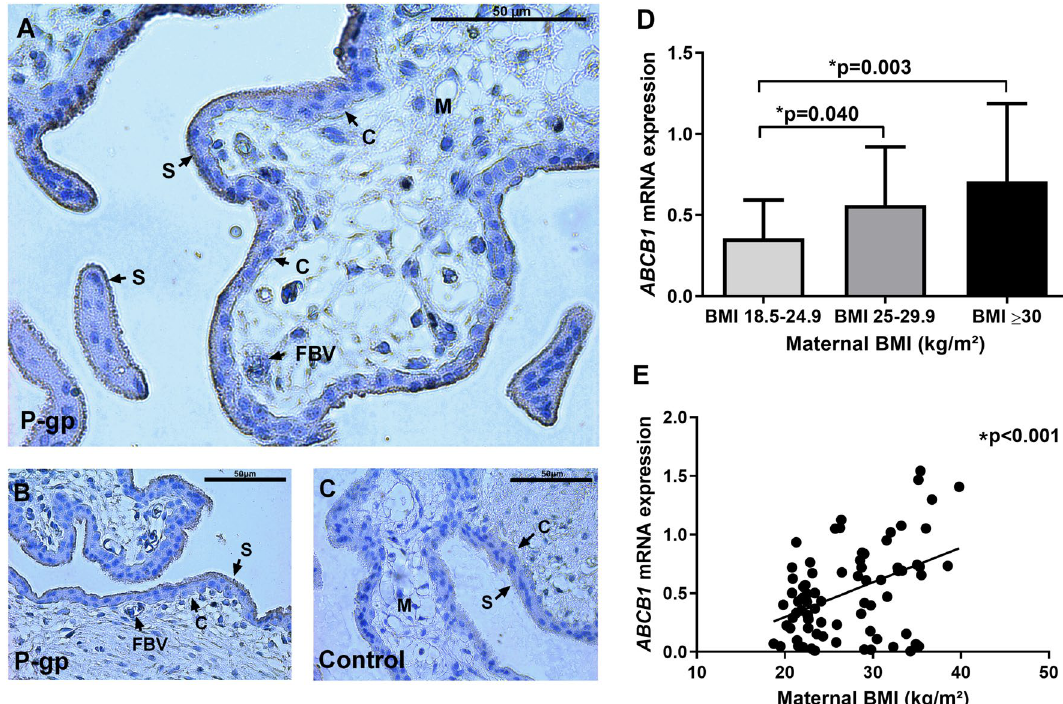
Figure 1. Localization of P-gp and ABCB1 mRNA expression in placental tissue. ( A , B ) Immunohistochemistry image of placental tissue using antibody against P-glycoprotein (P-gp) and stained with H&DAB. ( C ) Negative control without primary antibody. Arrowheads denote basophilic cytotrophoblastic cells (C), fetal blood vessel (FVB), mesenchyme (M), syncytiotrophoblastic layer (S). Magnification × 40. Scalebar represents 50 µM. Localization of P-gp in the apical membrane of the syncytiotrophoblast was confirmed, in addition to some faint immunostaining visible in the syncytiotrophoblast basolateral membrane. ( D ) ABCB1 mRNA expression in the three maternal BMI groups; normal weight (BMI: 18.5–24.9 kg/m 2 (n = 34)), overweight (BMI: 25–29.9 kg/m 2 (n = 18)), and obese (BMI ≥ 30 kg/m 2 (n = 23)) (Welch’s ANOVA, W(2.000,33.800) = 6.555, p = 0.004, was used due to unequal variance (Bartlett’s test, p = 0.002)). Statistically significant difference between the normal weight group and the overweight group (95% CI [0.011, 0.401], p = 0.040) and between the normal weight group and the obese group (95% CI [0.130, 0.571], p = 0.003) (post-hoc test: unpaired t-test with Welch’s correction). A p value < 0.05 was considered statistically significant. Each bar represents mean ± standard deviation (SD). ( E ) Expression of ABCB1 evaluated by linear regression. Each dot represents one sample (n = 75). Line represents best fitted line. Slope = 0.030, F(1,73) = 16.36, R 2 = 0.183, p < 0.001. A p value < 0.05 was considered statistically